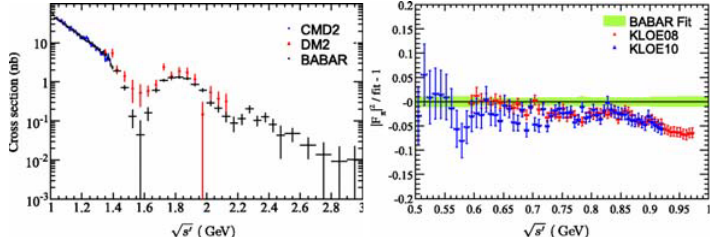
Figure 3. The e + e − → π + π − hadronic cross section at B A B AR and other experiments. On the left the comparison between B A B AR , CMD-2, and DM2 are shown. The systematic uncertainties range from the 0 . 5% of B A B AR , to the 0 . 8% of KLOE and CMD-2. On the right plot, in the region below 1GeV, the comparison between the pion form factors measured at B A B AR and KLOE is shown. A slight deviation between the two experiments can be observed above ρ peak